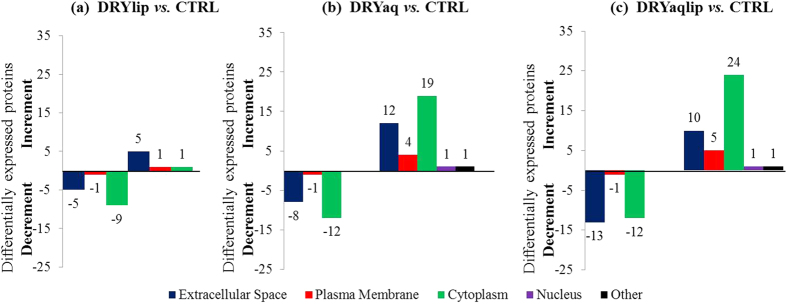
The bar charts shows the over-represented GOCC terms associated with the differentially expressed proteins analysed employing the Ingenuity Pathways Analysis software in (a) DRYlip vs. CTRL, (b) DRYaq vs. CTRL and (c) DRYaqlip vs. CTRL.